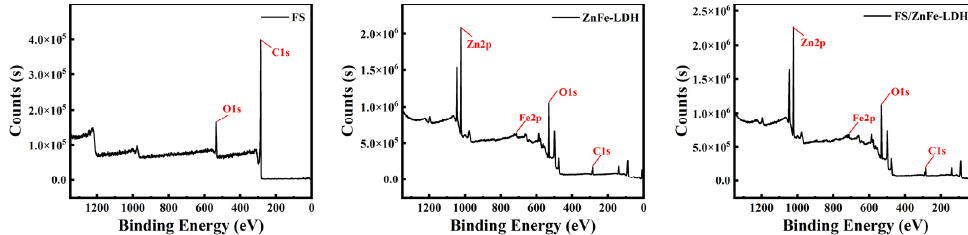
Figure 2. X-ray photoelectron spectroscopy(XPS) survey spectra of ZnFe-LDH, FS/ZnFe-LDH, and FS.